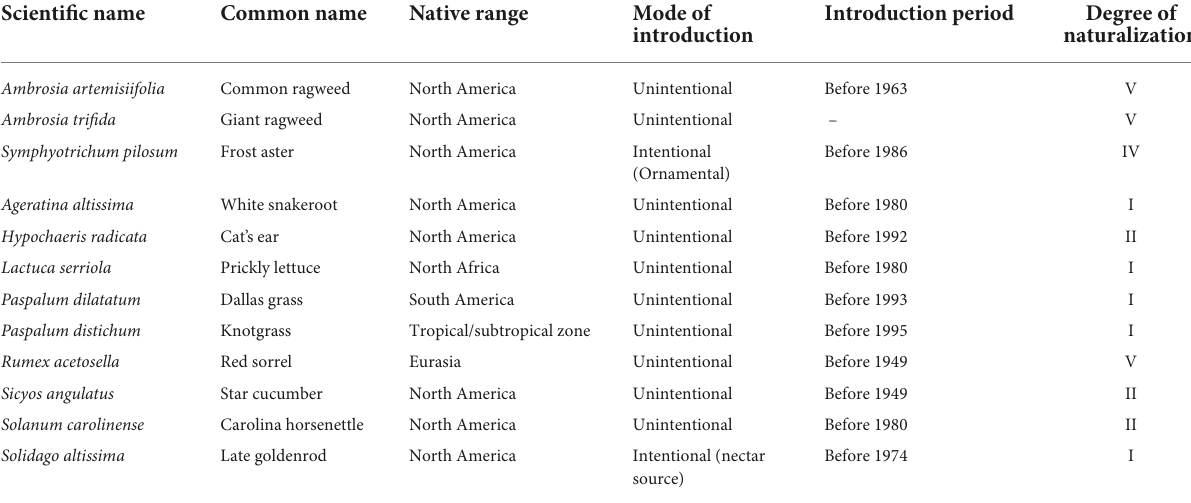
TABLE 1 List of ecosystem disturbing alien plant species (EDAPS) used in the